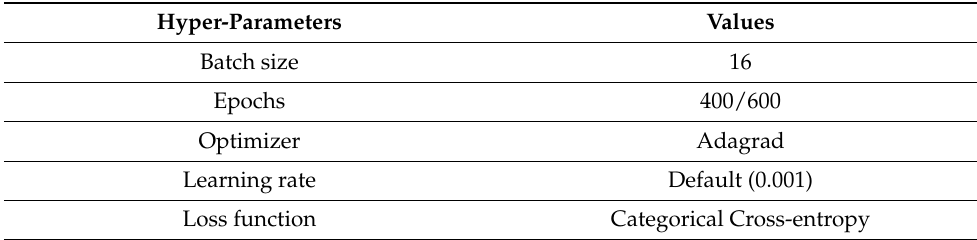
Table 2. Hyper-parameters set for this model. Hyper-Parameters Values Batch size